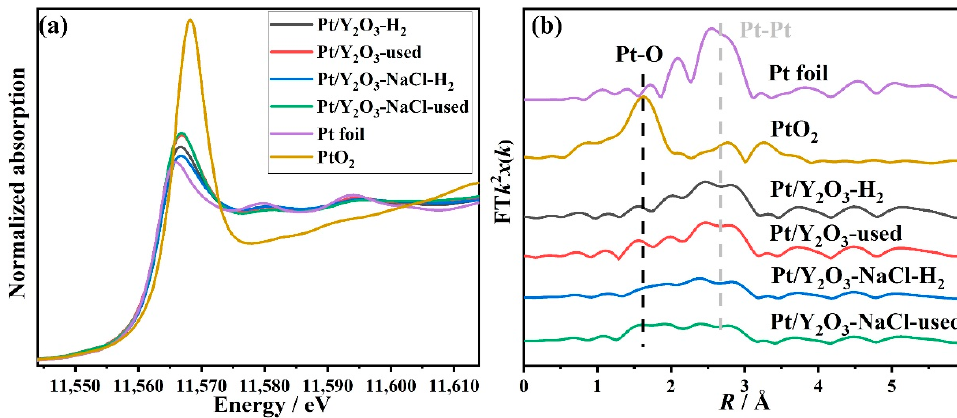
Figure 8. Pt L3-edge XANES profiles ( a ) and EXAFS fitting results ( b ) in R space for reduced and used Pt/Y 2 O 3 -NaCl and Pt/Y 2 O 3 catalysts. Table 3. EXAFS fitting results for reduced and used Pt/Y 2 O 3 -NaCl and Pt/Y 2 O 3 catalysts. Sample